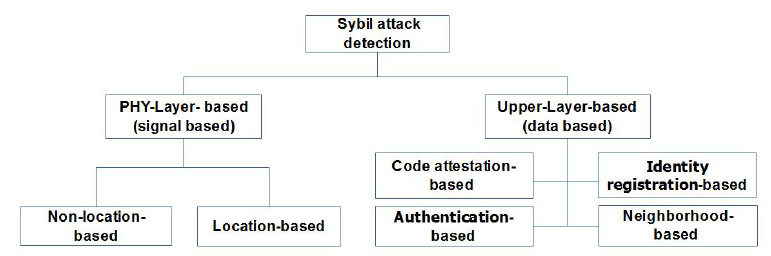
Figure 1. Categorization of Sybil attack detection algorithms in